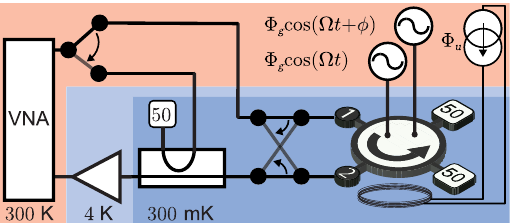
5. Simplified experimental schematic for circulator